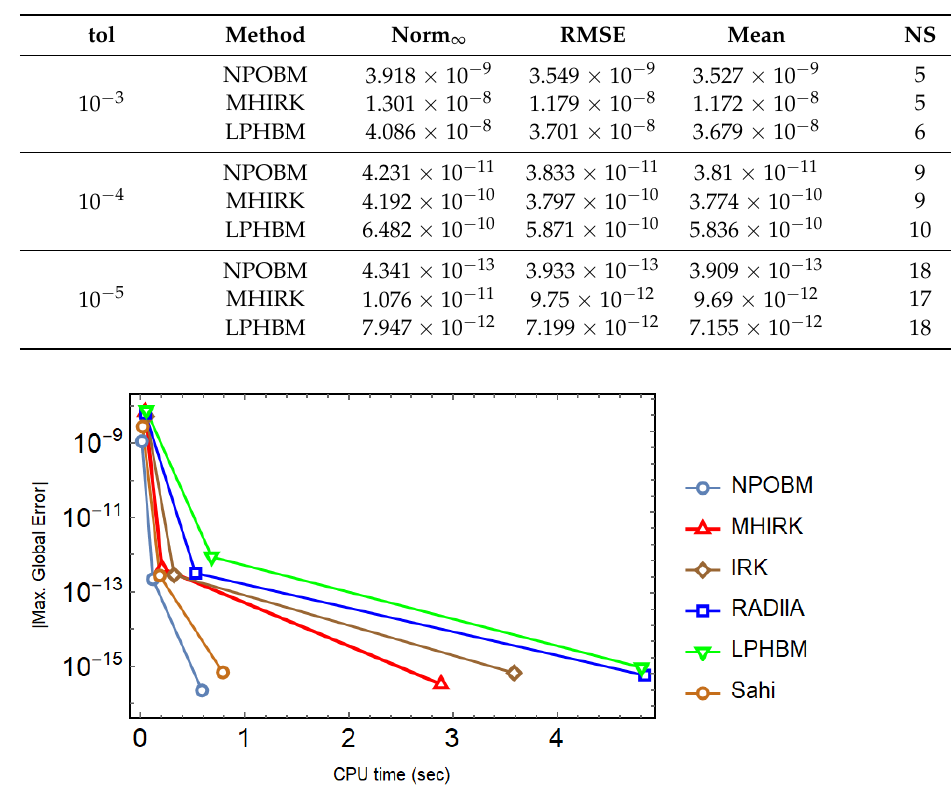
Figure 6. Efficiency curves for the system in Problem 2 to observe the behavior of absolute maximum global errors versus the CPU time (sec) with a logarithmic scale on y -axis.